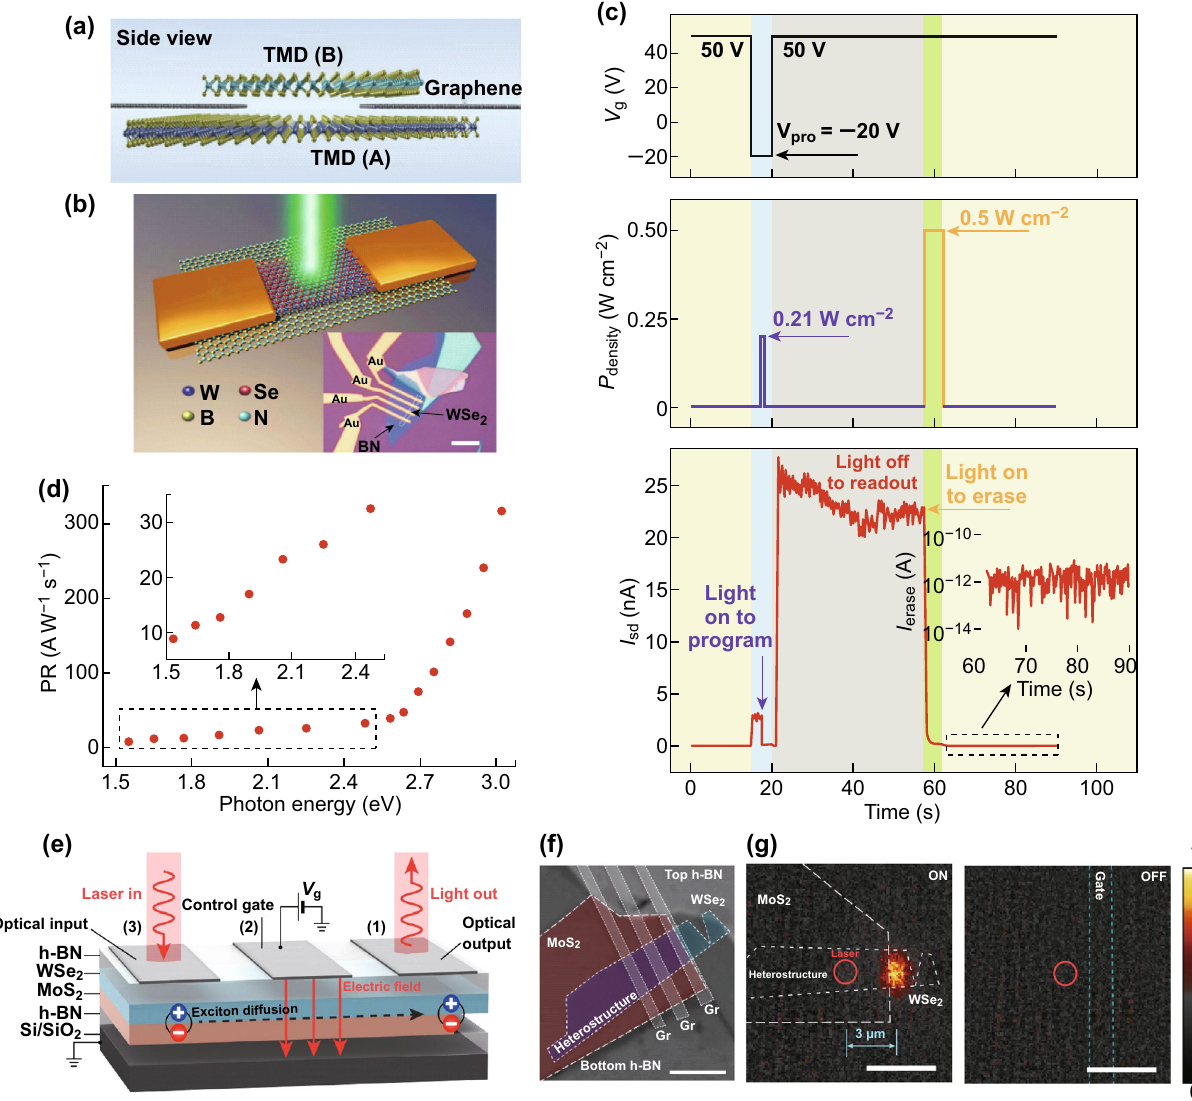
Fig. 9 2D heterostructures in optoelectronic applications. a Schematic diagram of TMD/TMD heterostructure with a graphene contact. Reprinted with permission from Ref. [42]. Schematic and optical picture of optoelectronic memory based on hBN/WSe 2 heterostructure ( b ) and the modulation of programming, reading and erasing state by V g and incident illumination ( c ), and the wavelength‑dependent PR ( d ). Reprinted with permission from Ref. [112]. Schematic and optical picture ( e , f ) of the multi‑gate exciton device. The excitation region is marked by the red circle, and the recombination of the interlayer excitons occurs at the edge of the heterostructure. The modulation of exciton flux by V g at room temperature is illustrated in diagram ( g ). Reprinted with permission from Ref.